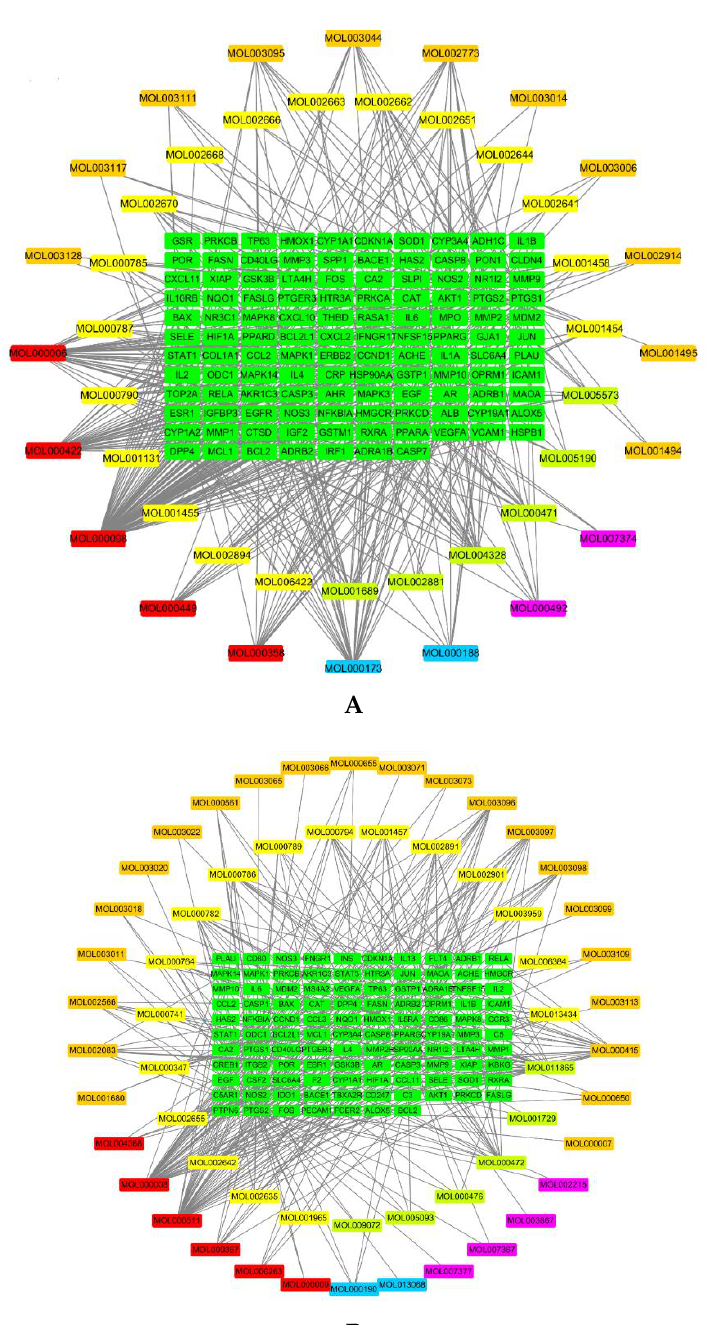
Figure 2. Compound–intersection targets network analysis. ( A ) Network of 43 compounds (OB ≥ 30% and DL ≥ 0.18) and intersection targets between compound and AD-related targets. ( B ) Network of 57 compounds (OB < 30% and DL ≥ 0.18) and intersection targets between compound and AD-related targets. The green rectangles represent PHF targets against AD; the Kelly green, yellow, orange, blue, and violet rectangles represent compounds from HM, CP, FL, RA, and CM, respectively. The red rectangles represent compounds from more than two herbs in PHF. PHF: Pentaherbs Formula; AD: atopic dermatitis; OB: oral bioavailability; DL: drug-likeness; CM: Cortex Moutan; CP: Cortex Phellodendri; FL: Flos Lonicerae; HM: Herba Menthae; RA: Rhizoma Atractylodis.